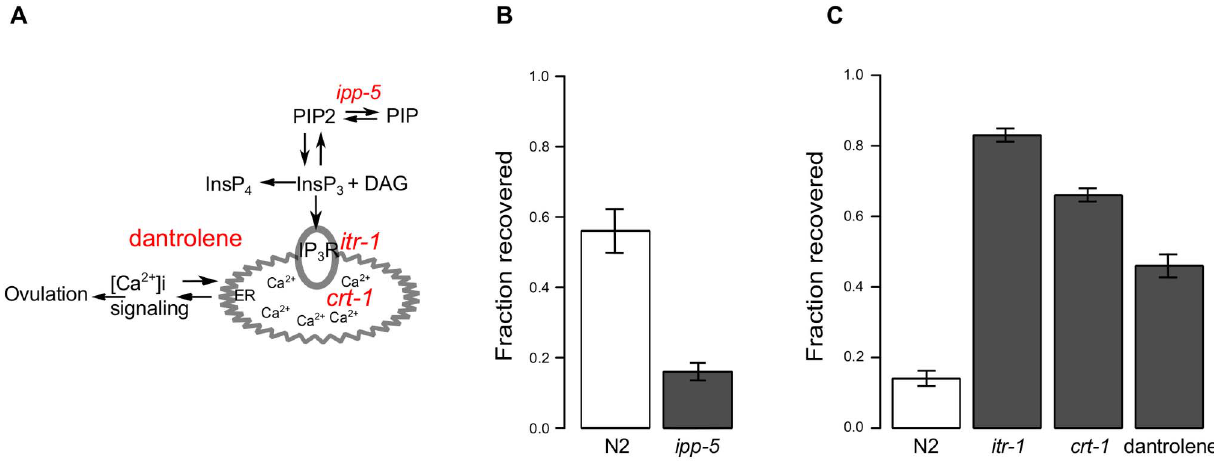
Figure 6. Mutants with altered ovulation dynamics recover from heat stress differently than the wild type. (A) Schematic depiction of several key components of Ca 2 + signaling that regulates ovulation. Modified from [53]. (B) Recovery of fecundity (after a 24-hour heat stress at 31 u C) in a mutant with up-regulated Ca 2 + signaling is lower than in a wild type control (binomial test p =4.3 6 10 2 9 ). (C) Recovery of fecundity (after a 24- hour heat stress at 29 u C) of mutants or chemical treatment that down-regulate Ca 2 + signaling is higher than in a wild type control: itr-1 (binomial test p =7.7 6 10 2 28 ), crt-1 ( p =2 6 10 2 25 ), and dantrolene ( p =1.6 6 10 2 8 ). Error bars are s.d.